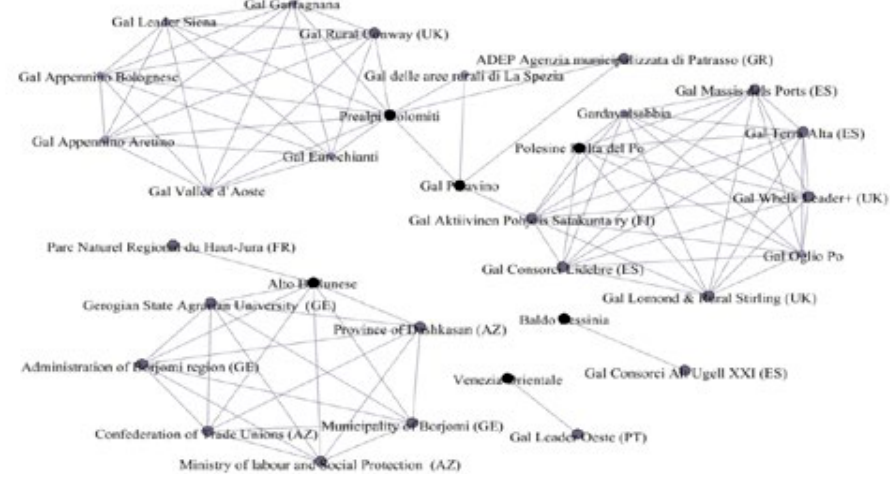
Figure 3. Transnational cooperation network of Veneto LAGs, LEADER